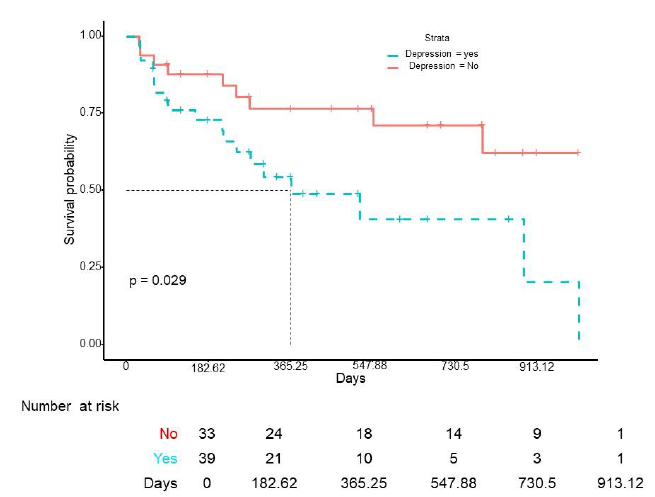
Figure 2. Ixekizumab survival curve according to previous exposure to methotrexate.